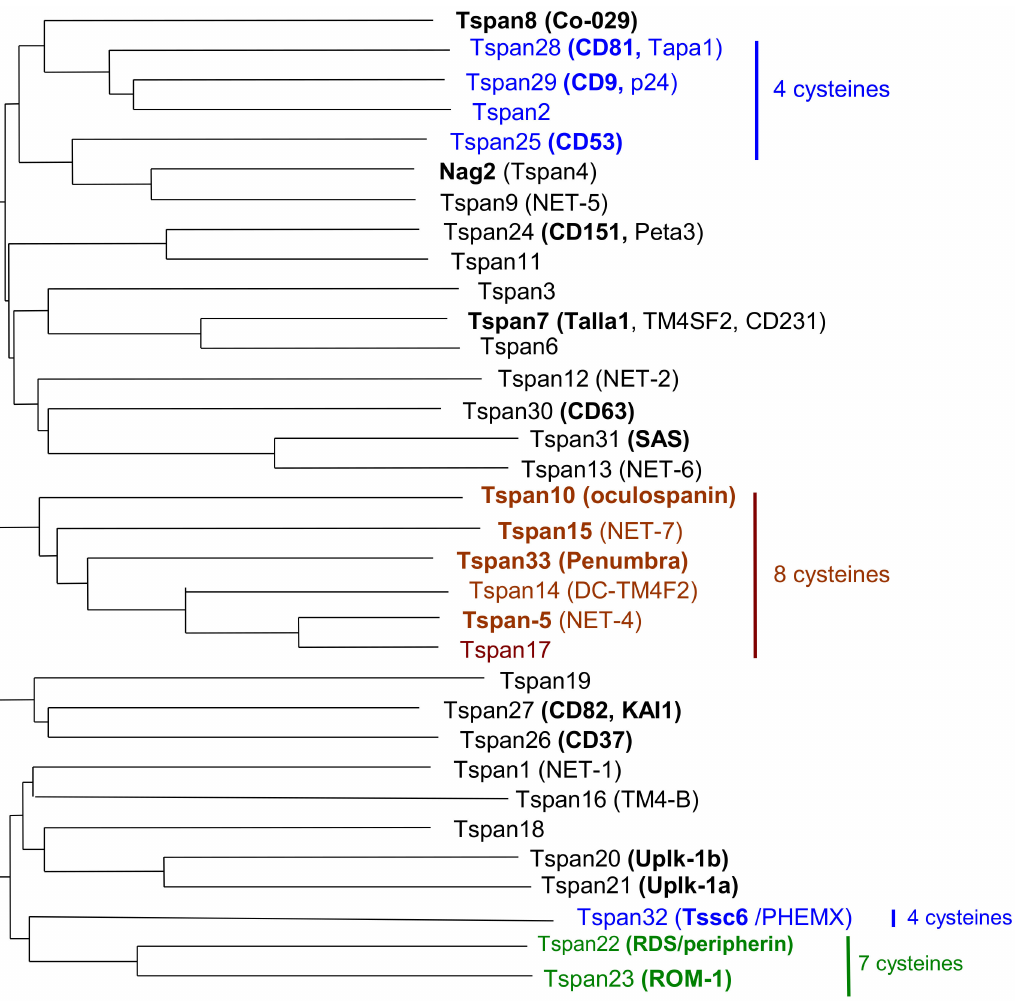
Figure 1. Homology tree between human tetraspanins. Protein sequences have been aligned to generate this distance tree. Bolded names correspond to commonly used ones. The number of cysteines in the extracellular loop EC2 is given when they are different from six